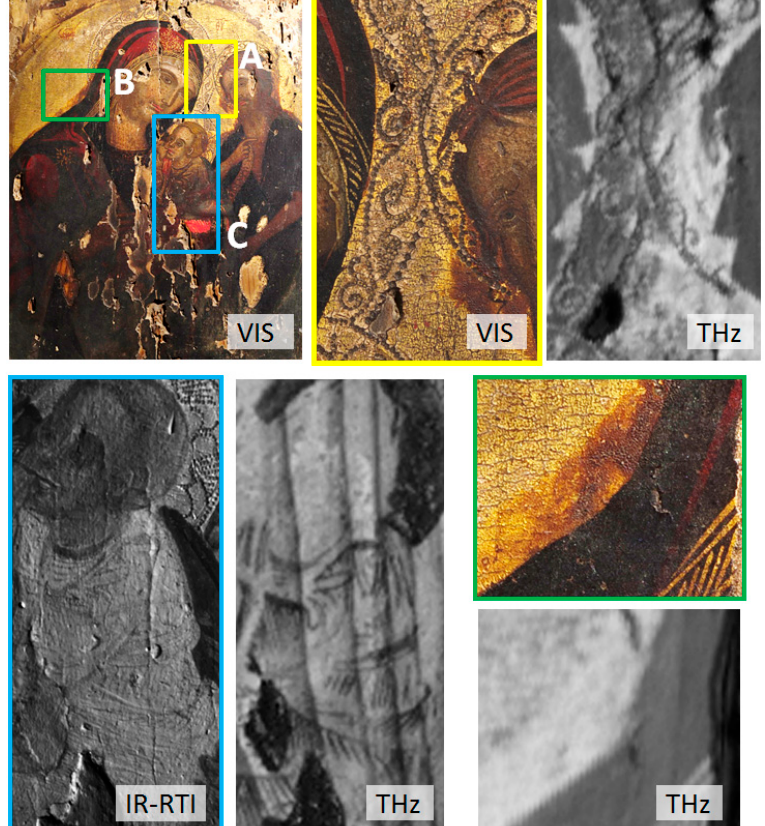
Figure 3. Virgin with Child and a Saint, 14th century icon (32 cm × 39 cm × 0.8 cm), Public Library